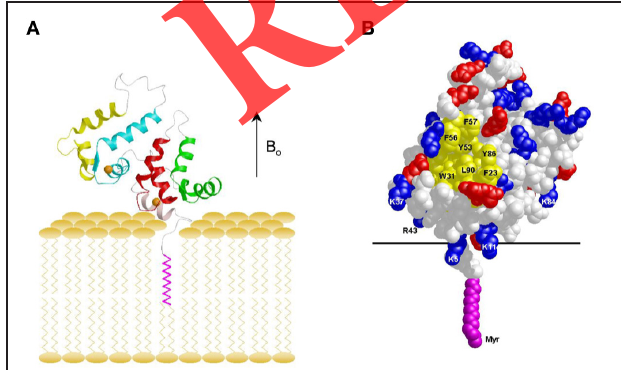
FIGURE 4 | Main chain structure (A) and space-filling representation (B) of myristoylated recoverin bound to oriented lipid bilayers determined by solid-state NMR [Valentine et al. (2003)]. Hydrophobic residues are yellow, bound Ca 2 + ions are orange, and charged residues are red and